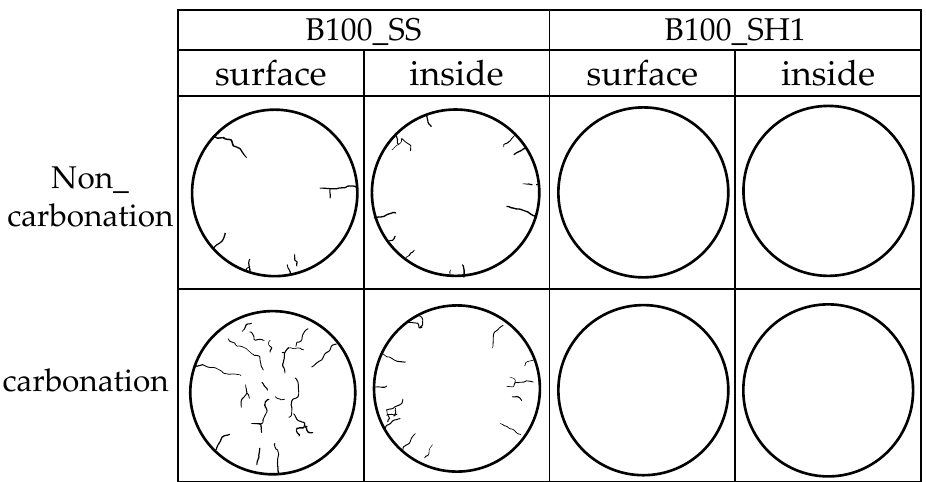
Figure 18. Crack observation of 12 weeks (accelerated carbonation 4 weeks).